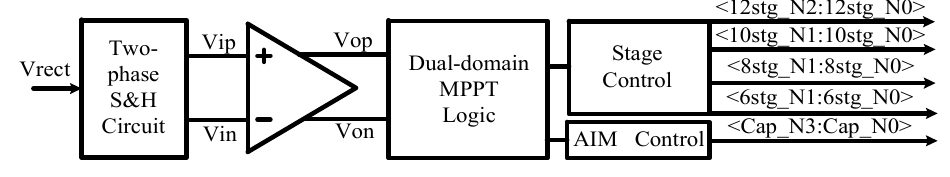
Figure 6. The MPPT controller.